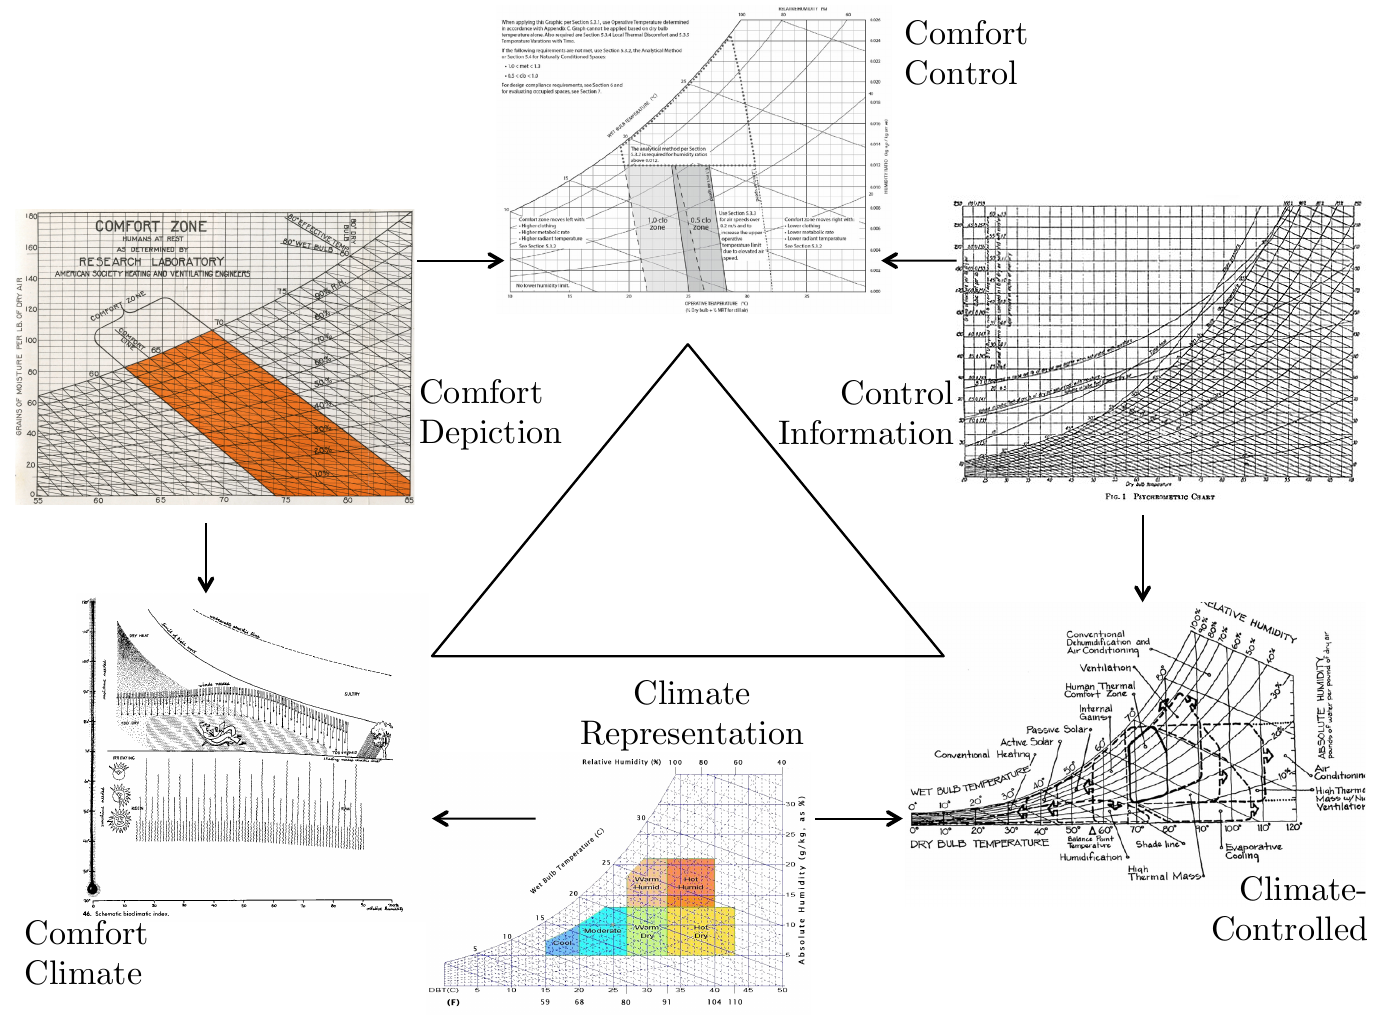
Figure 5. Use of psychrometrics throughout comfort, controls, and climate frameworks, combining pure psychrometric representations along the lines of the triangle into applied frameworks at the vertices. Beginning with the “Comfort Control” chart and proceeding clockwise, references for each chart are provided